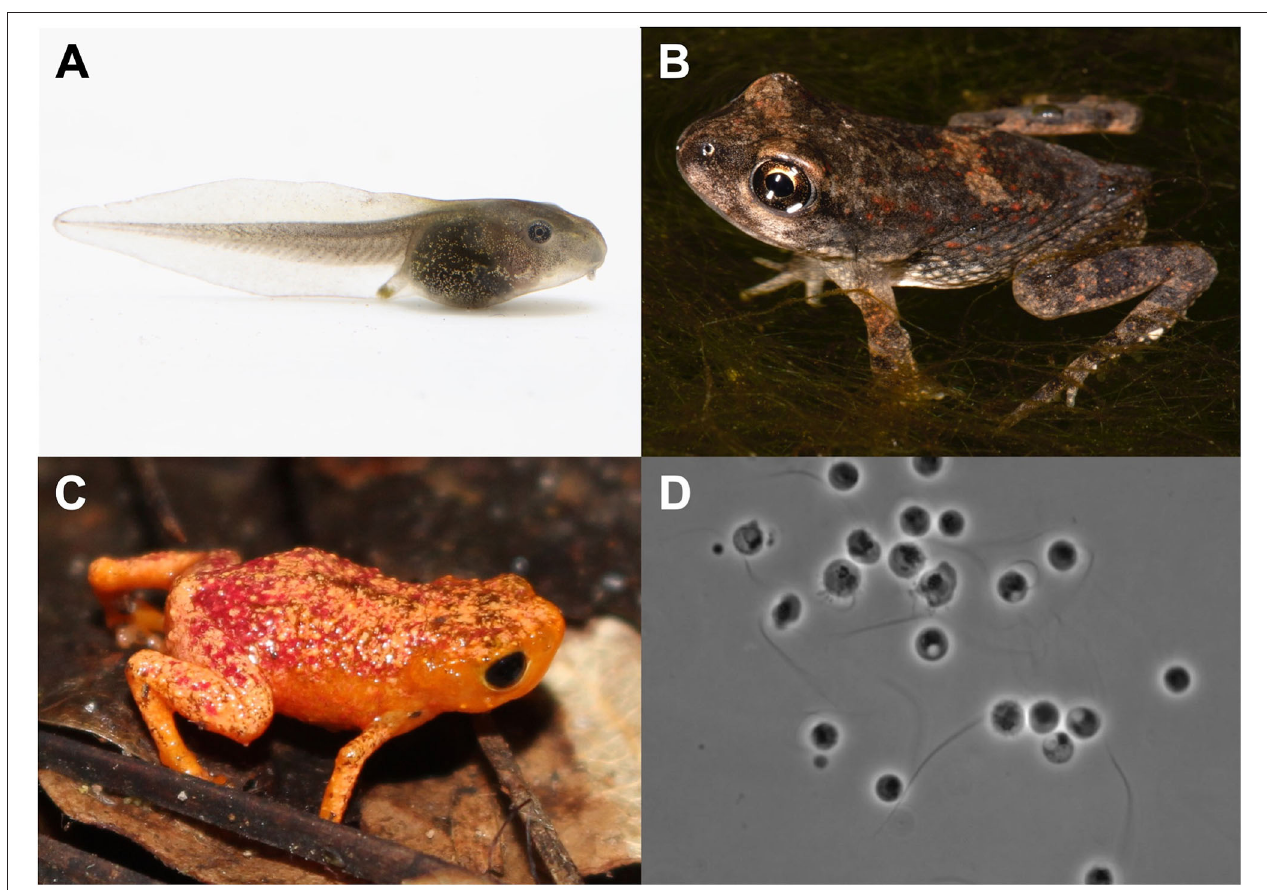
FIGURE 1 | Select study organisms included in the meta-analysis. (A) Rana sylvatica (wood frog) larva. This is one of three species for which data were available for larval experimental infections. Photo by Brian Gratwicke. (B) Bufonid metamorph. Recently metamorphosed amphibians are believed to be particularly susceptible to chytridiomycosis. Photo by Todd Pierson. (C) Brachycephalus pitanga (pumpkin toadlet) is a tiny terrestrial direct developer and is endemic to Brazil’s Atlantic Forest. Photo by Anat Belasen. (D) Batrachochytrium dendrobatidis zoospores on 1%T visualized under a stereoscope. Photo by Joyce